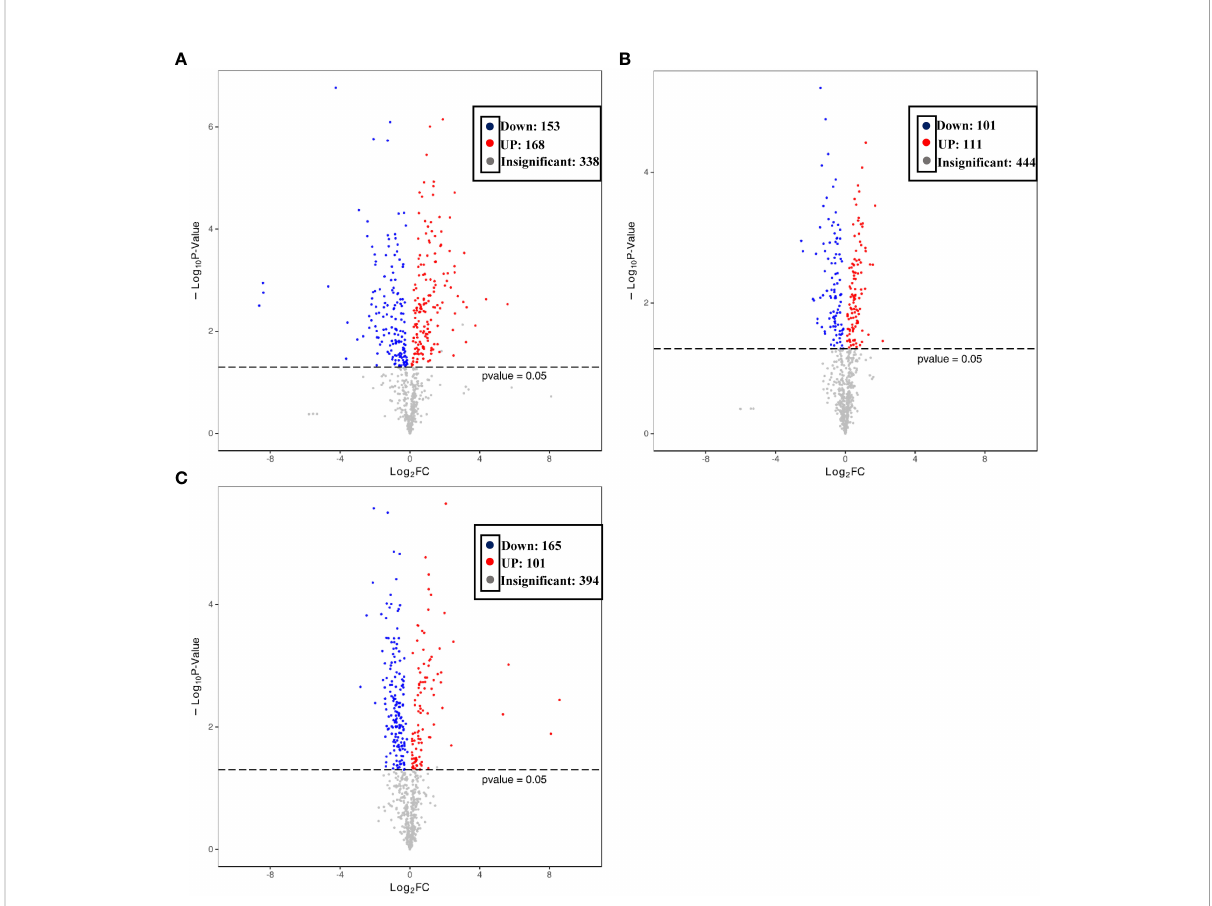
FIGURE 5 Volcano plot of the differentially accumulated metabolites under different treatments: (A) Cd treatment vs. control, (B) La treatment vs. control, (C) Cd + La treatment vs. Cd treatment. Each origin in the volcano plot represents a metabolite: the red origin denotes up-regulated metabolites, and the blue bar refers to down-regulated metabolites. The abscissa represents the logarithmic fold change of metabolites in two groups. Ordinate represents the signi fi cance level of different